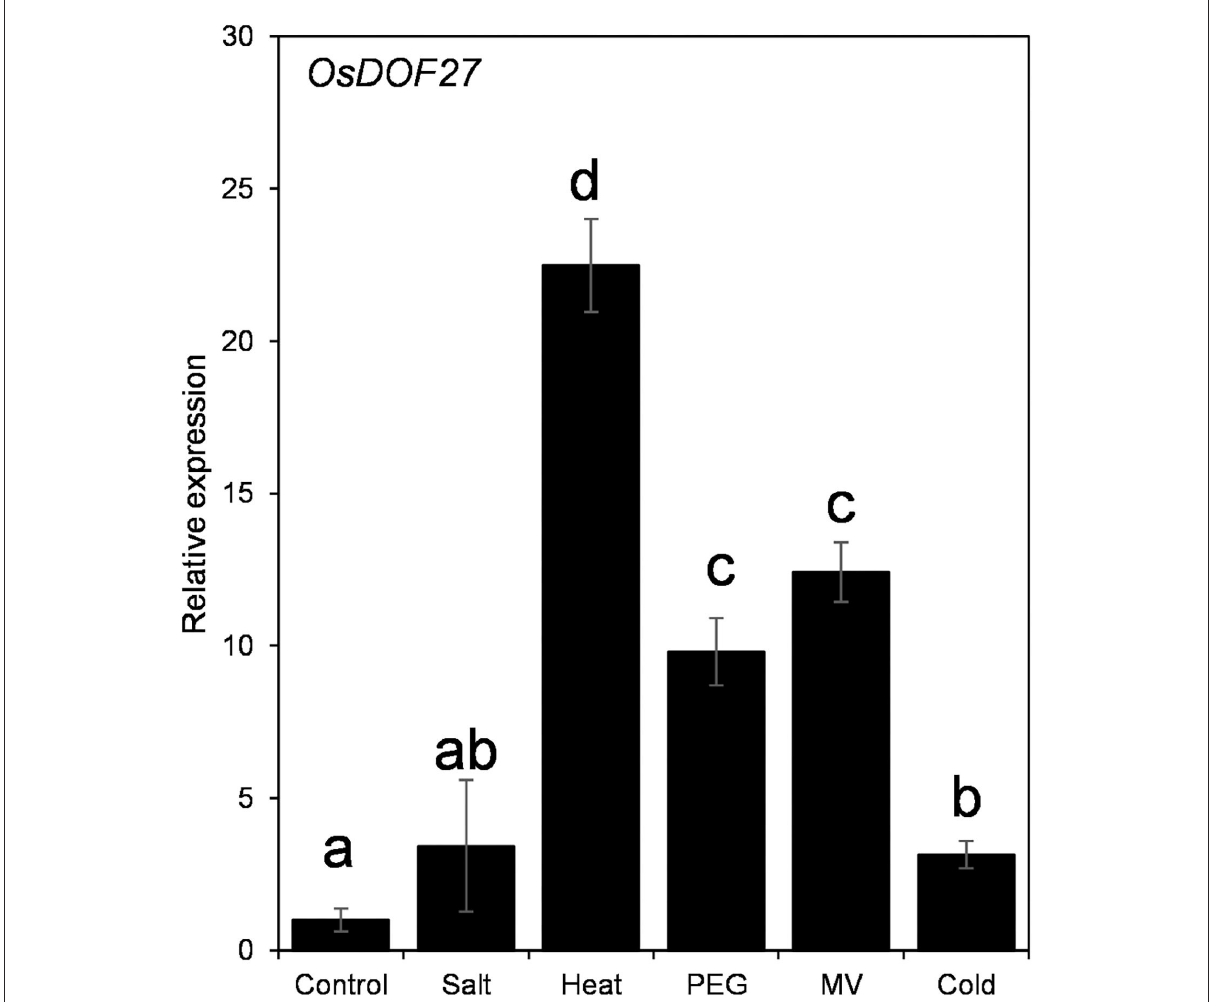
FIGURE1 qRT-PCR for expression analysis of OsDOF27 under different abiotic stress conditions including salt, heat, PEG, methyl viologen, and cold. Seven-day-old rice seedlings were treated with abiotic stressors (20% PEG, 200mM NaCl, heat (42 ◦ C), cold (4 ◦ C), and methyl viologen (20 µ M). Total RNA was extracted, and cDNA was synthesized, followed by qPCR. Two endogenous controls (Ubiquitin-5 and EF1 α ) were used to normalize the relative expression value of OsDOF27 followed by a calculation using the 11 CT method. The error bars represent the standard deviation of triplicate analysis. The significant difference in the mean of the values is indicated by different letters ( α =